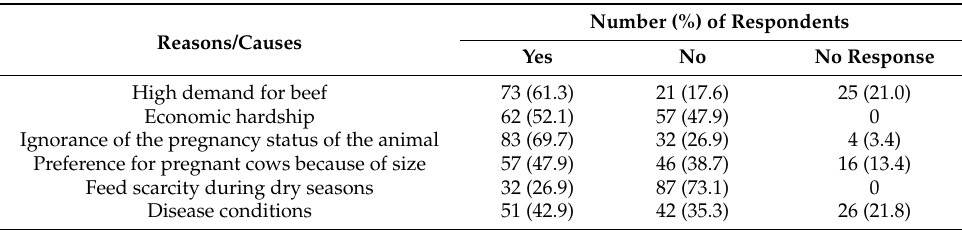
Table 2. Reasons for sale or slaughter of pregnant cows for meat among herders and abattoir workers ( n = 119 *) in South-Eastern Nigeria.